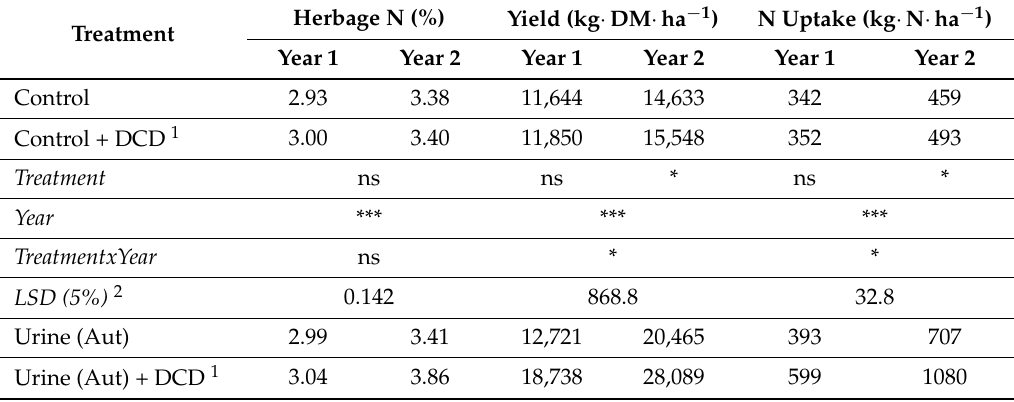
Table 1. Annual mean values of pasture nitrogen (N) concentrations, dry matter (DM) yields and pasture shoot N